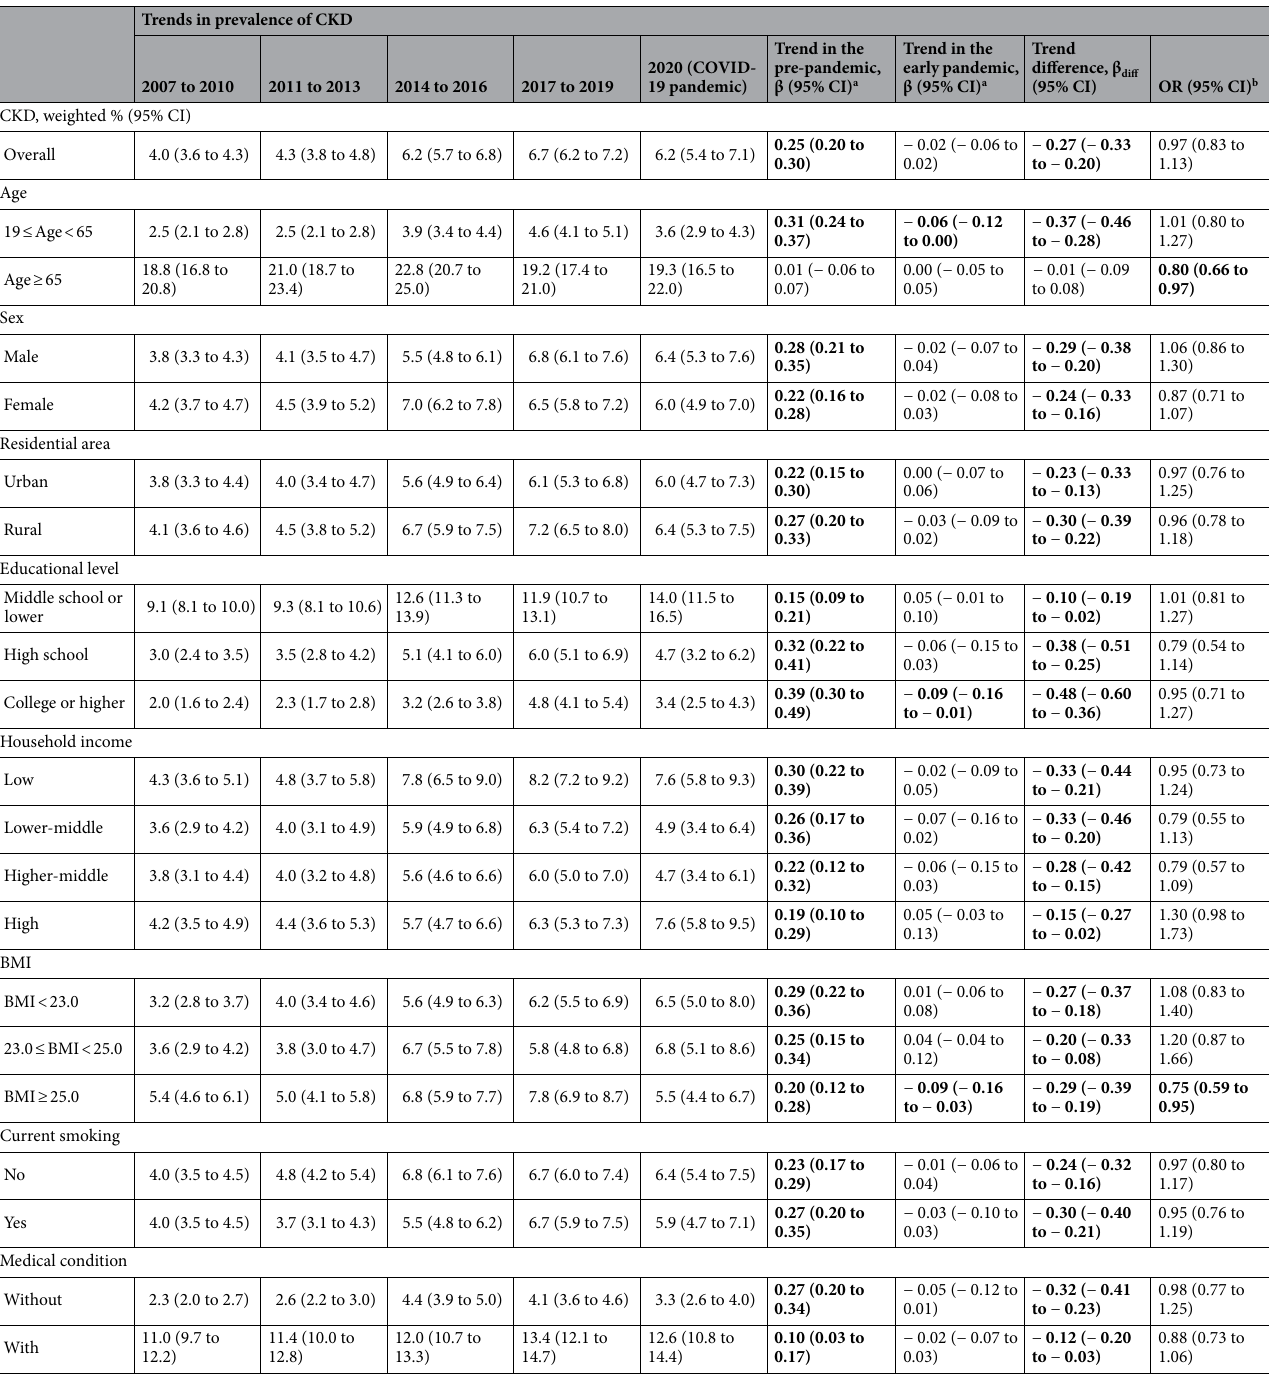
Table 3. Chronic kidney disease weighted prevalence and trend in adults who did not visit outpatient clinic within 2 weeks from 2007–2020. BMI body mass index, CKD chronic kidney disease, CI confidence interval, KNHANES Korea National Health and Nutrition Examination Survey, OR odds ratio. a Estimated β was calculated to analyze the year cycle (2007–2010, 2011–2013, 2014–2016, 2017–2019, and 2020) as a continuous variable using a linear regression model. b Estimated OR was calculated to analyze the year cycle (2017–2019 versus 2020 [COVID-19 pandemic]) as a categorical variable using a logistic regression model. The numbers in bold indicate a significant difference ( p <